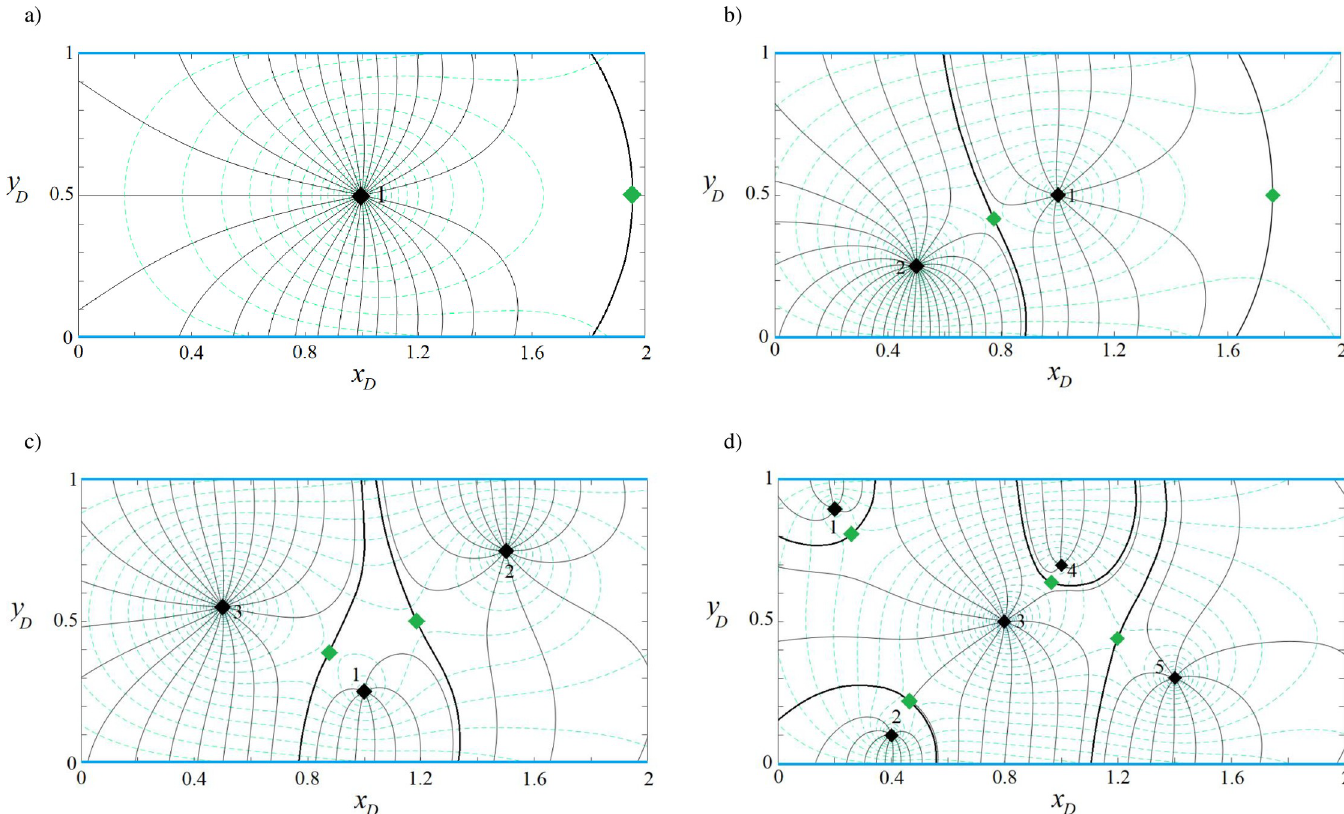
Fig 4. Velocity potential (dashed lines) and stream function (solid grey lines) for one (a), two (b), three (c) and five (d) wells in a strip-shaped aquifer with inflow- inflow boundaries. In this figure and Figs 5–7: β = 0. Thick black curves show the limit of the capture envelopes and black and green diamonds represent wells and stagnation points,